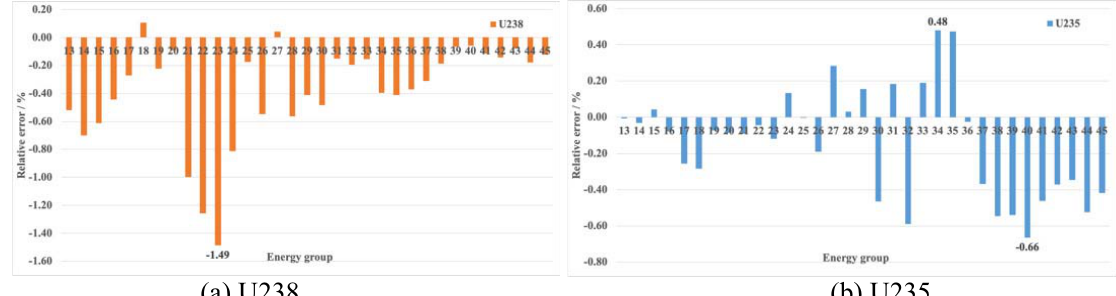
Figure 7. The absorption cross sections difference of one plate fuel pin cell problem